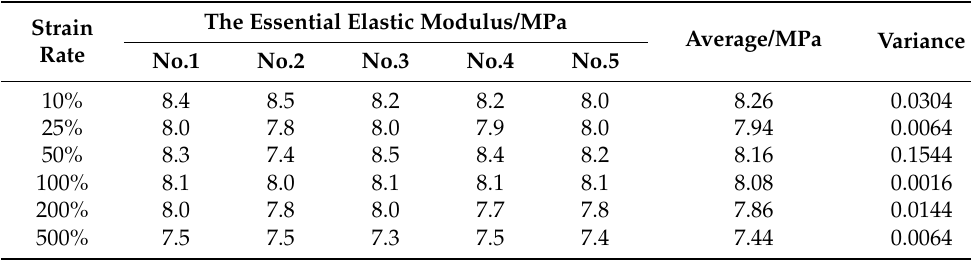
Average/MPa Variance